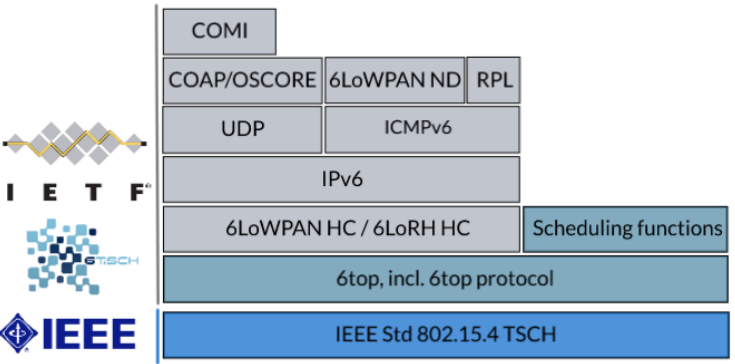
Figure 2. The 6TiSCH protocol